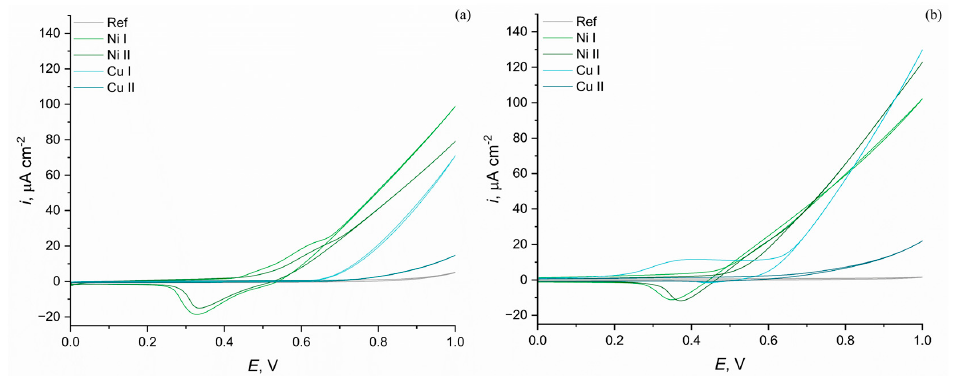
Figure 8. Results of samples’ cyclic voltammetry in ( a ) 1 M KOH solution and ( b ) 1 M KOH + 0.15 M urea solution. urea